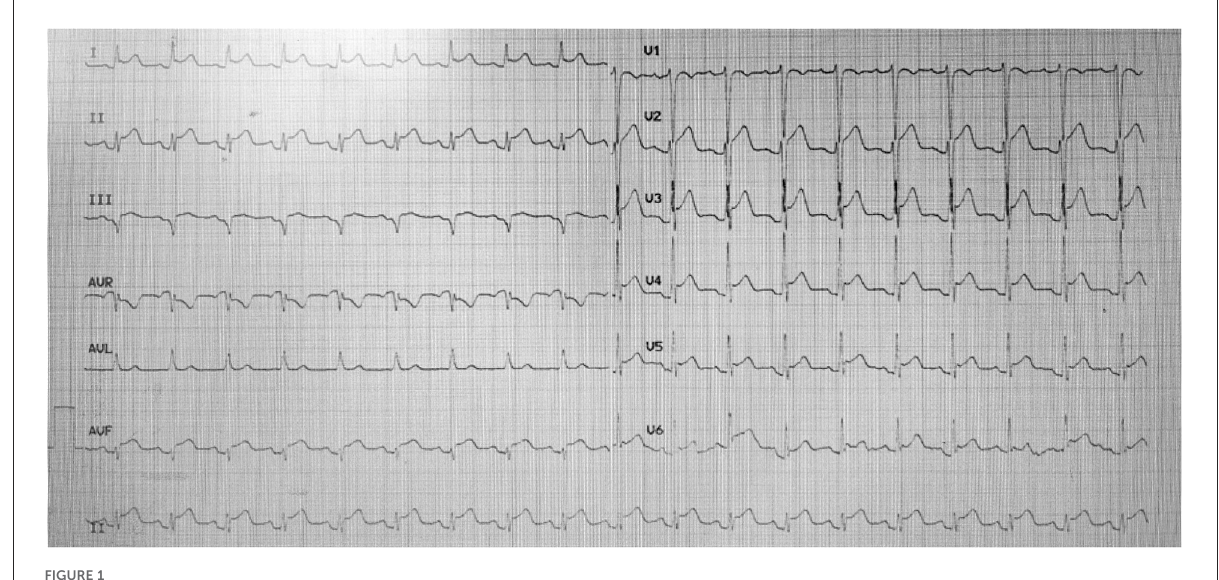
FIGURE1 Emergency electrocardiogram in August